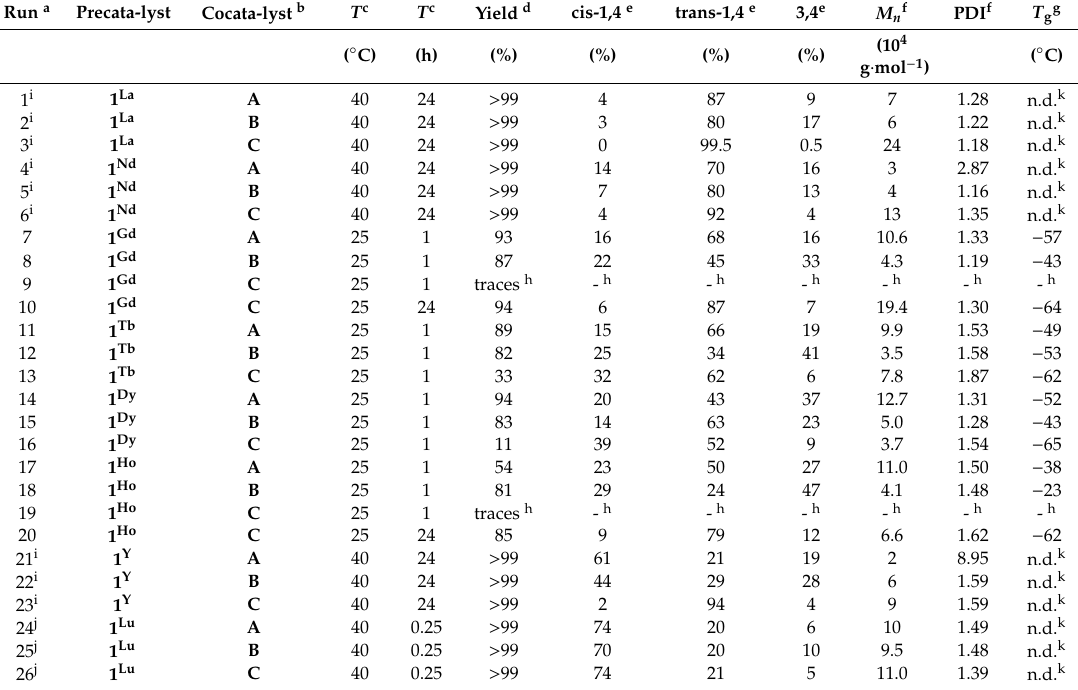
Table 2. Isoprene homopolymerization by [Cp*Ln(AlMe 4 ) 2 ] ( 1 Ln ).